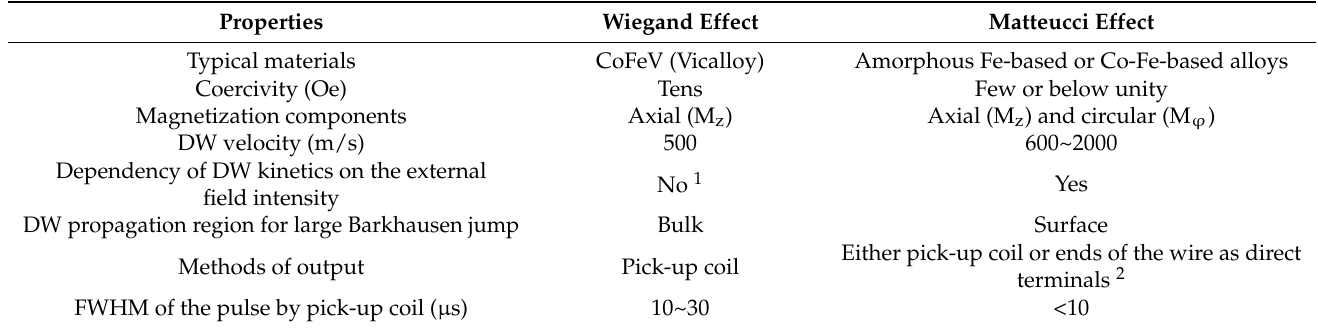
Table 1. Comparison of the Wiegand effect and Matteucci effect of micro-wires, both of which produce a large Barkhausen effect